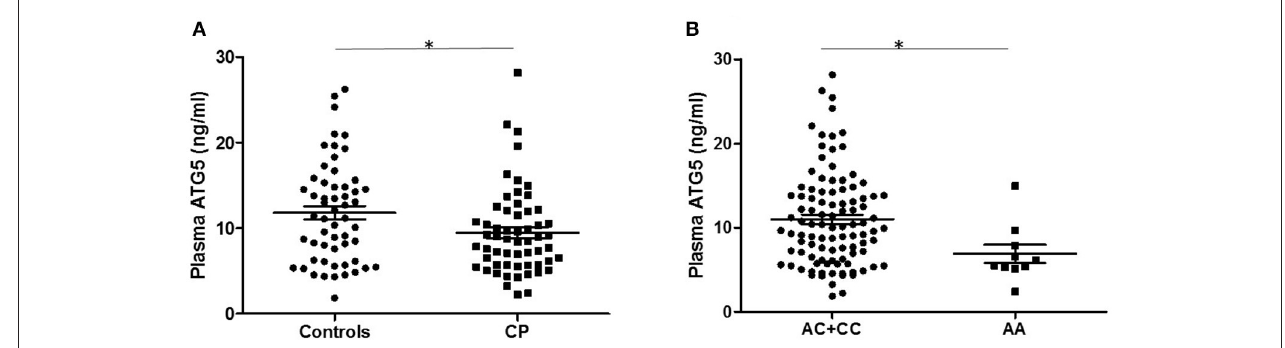
FIGURE 1 | Plasma ATG5 concentrations in patients with controls and CP. (A) Distribution of plasma ATG5 concentrations between all patients with controls (56 participants) and CP (58 patients). (B) Plasma ATG5 levels in individuals carrying different genotypes of rs6568431 (AC + CC = 100, AA = 10). Each dot represents one individual, and each bar represents the mean value. * P < 0.05; Student’s two-tailed t -test; CP, cerebral